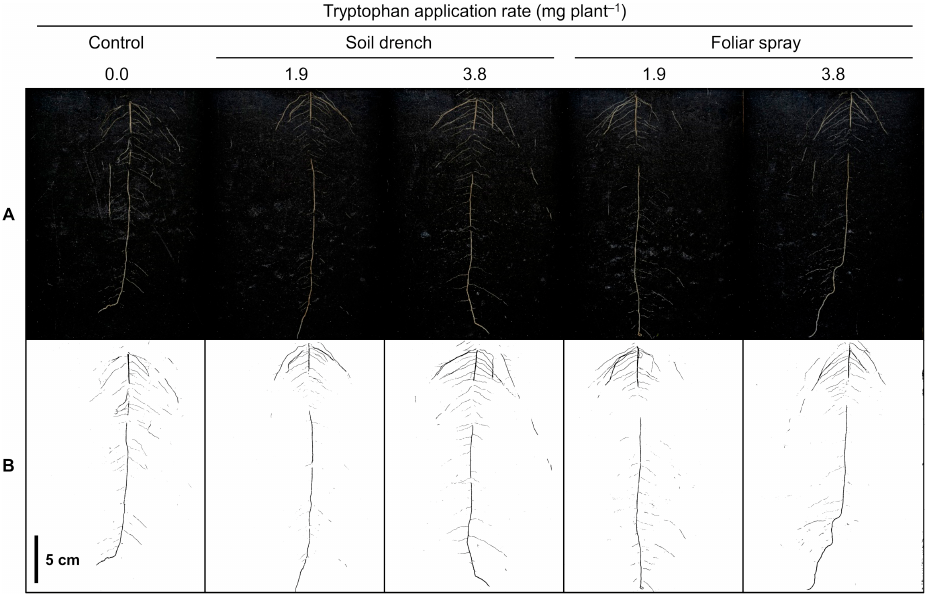
Figure 2. Rhizotron root images of soybean seedlings at 18 days after sowing: ( A ) color images; ( B ) binary images processed by ImageJ software. Tryptophan treatments were as described in Figure 1. Table 2. Root projected area of soybean seedlings as affected by tryptophan (TP) soil drench and foliar spray treatments 1 .